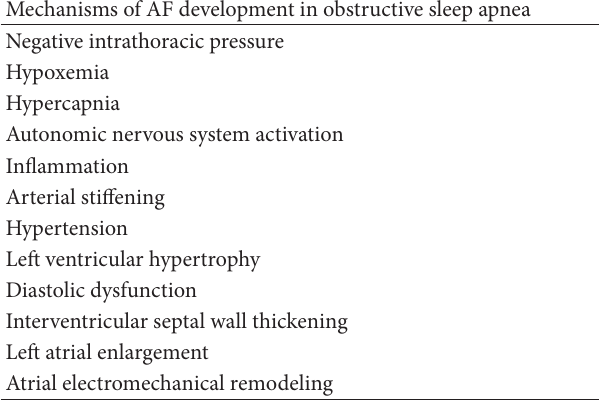
Table 2: Pathophysiologic